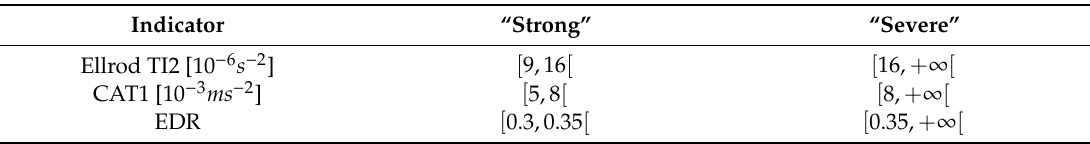
Figure A1. ( a ) Regime flow diagram adapted from Bauer et al. [2] for conditions of Flight 1; ( b ) Regime flow diagram adapted from Grubiši´c et al. [5] for conditions of Flight 2. Red mark indicates predicted states according to results from this study. Pico’s orography is approximately circular (unitary horizontal aspect ratio). Table A1. Suggested preliminary thresholds for three turbulence indicators. The thresholds values of EDR are only valid for heights below 500 ft (152 m).